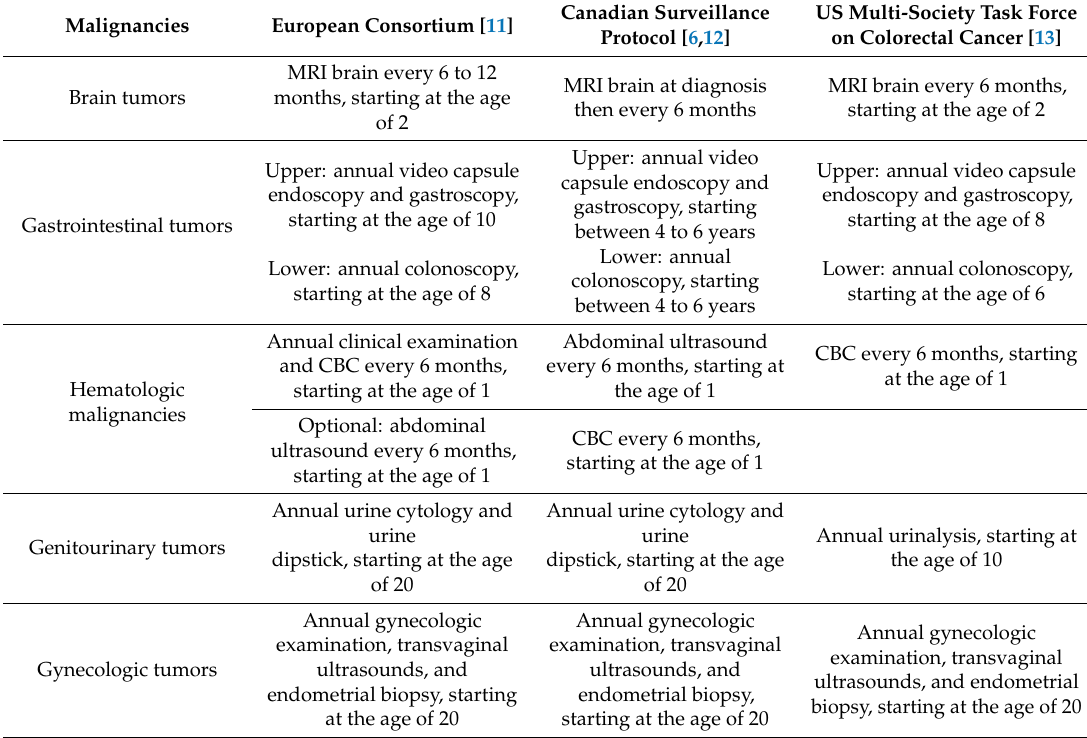
Table 1. European Consortium, Canadian and US Multi-society Task Force on Colorectal Cancer Constitutional mismatch repair deficiency (CMMRD) surveillance